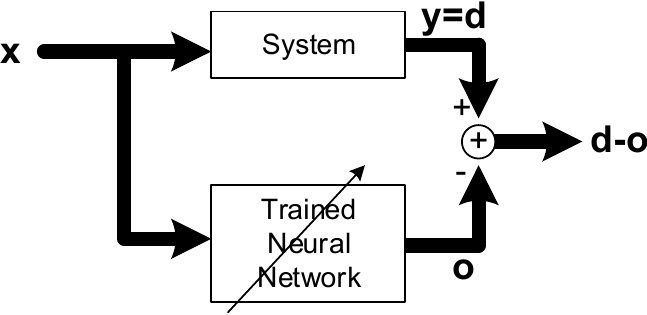
Figure 1. Concept of system identification with artificial neural networks, where lines with arrow heads denote parameter adjustment via learning.